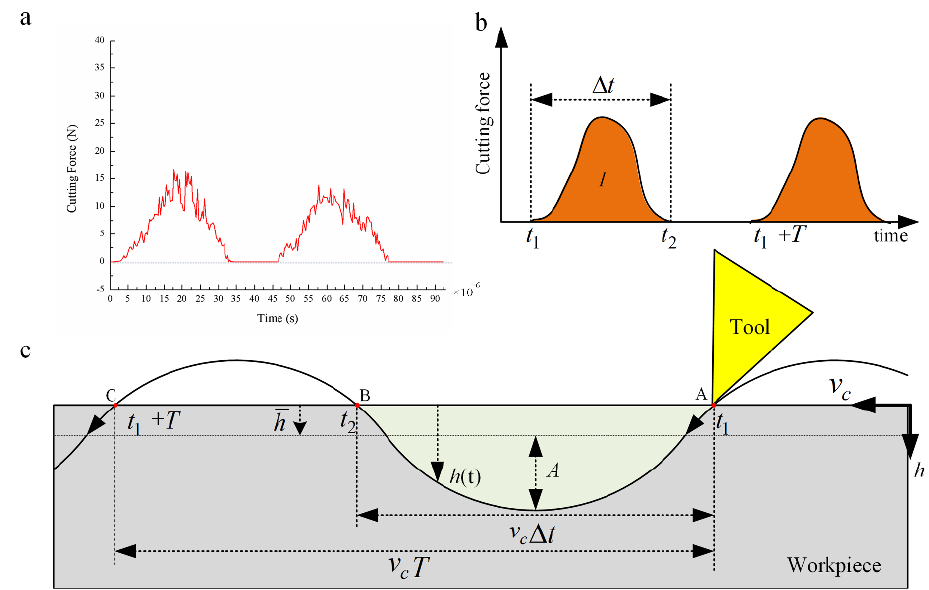
Figure 4. Schematics for calculation of the influence of ultrasonic impact: ( a ) transient cutting force signal [46], ( b ) impulse for each vibration cycle, and ( c ) concise transient cutting force calculation model. t 1 , cut-in moment, t 2 , cutting-out moment, ∆ t , cutting duration, T , ultrasonic vibration period, I , impact impulse, A , ultrasonic vibration amplitude, v c , cutting speed, h , cutting